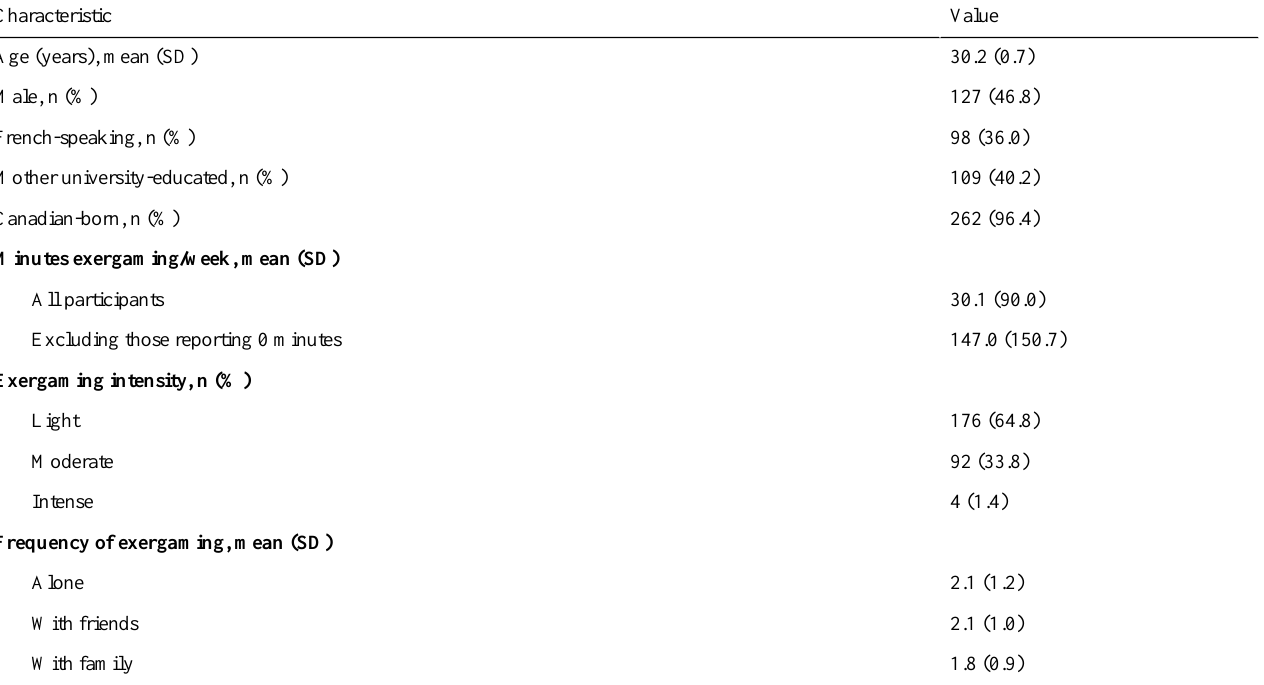
Table 1. Selected characteristics of participants in Study 1 (N=272), NDIT